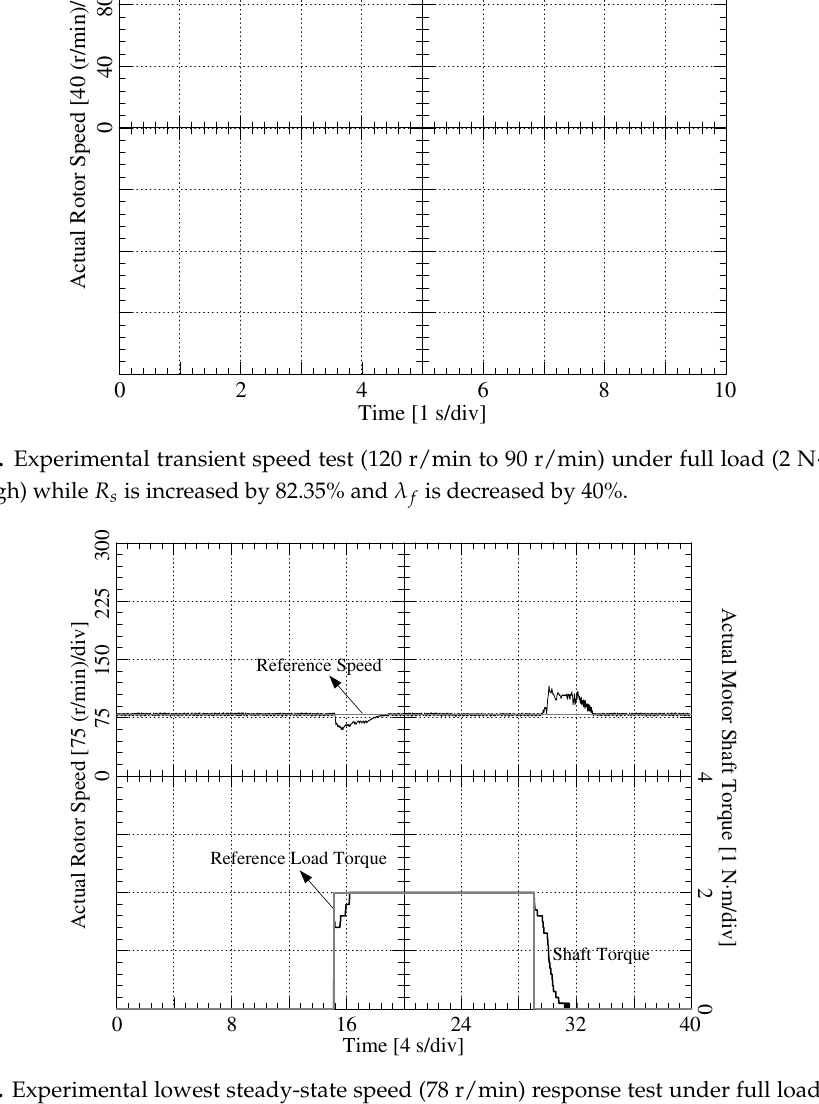
Figure 15. Experimental lowest steady-state speed (78 r/min) response test under full load (2 N·m) injection and rejection with K = 5 (high) while R s is increased by 82.35% and λ f is decreased by